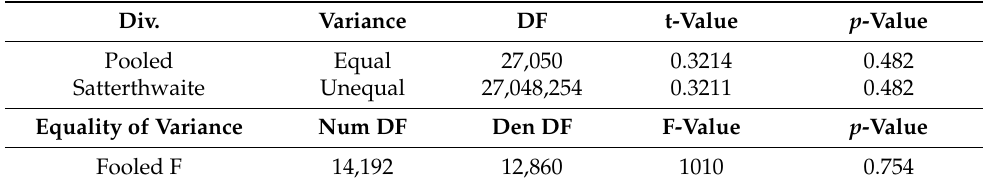
Table 10. Two-sample t -test for H1c